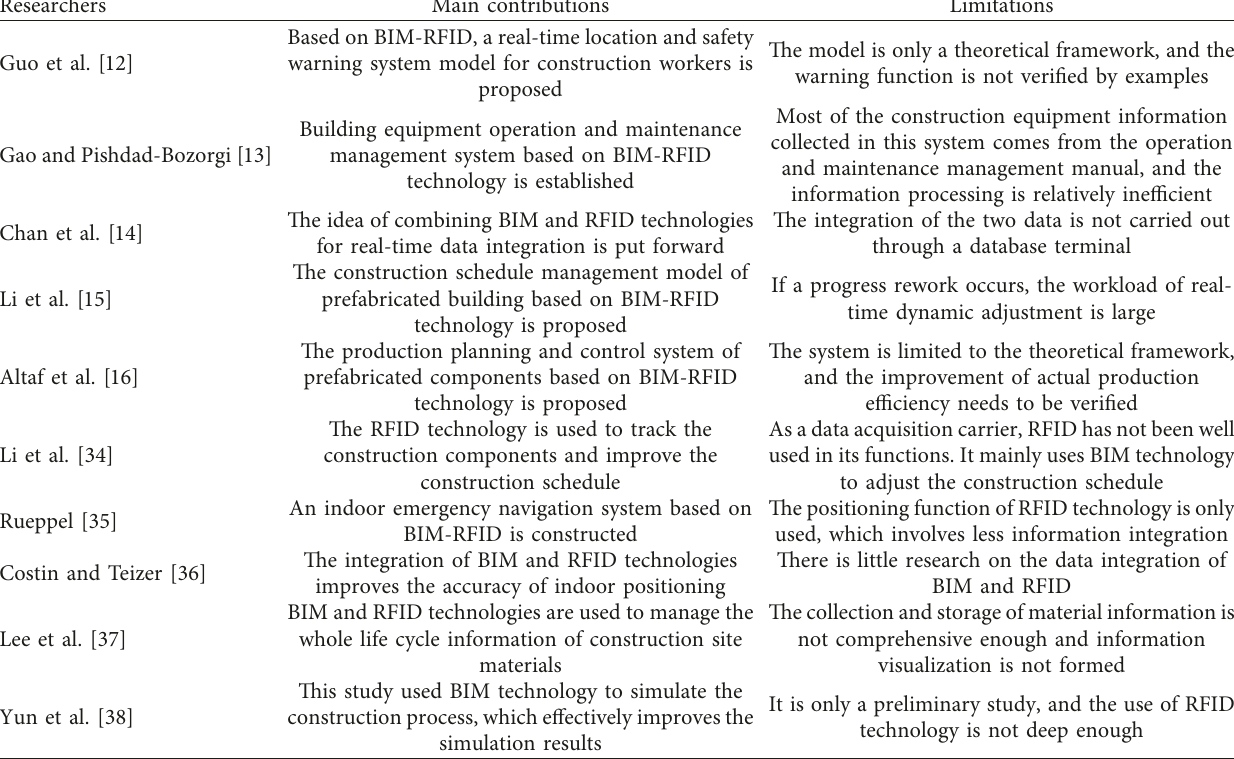
Table 1: Research status of integrated management of BIM-RFID